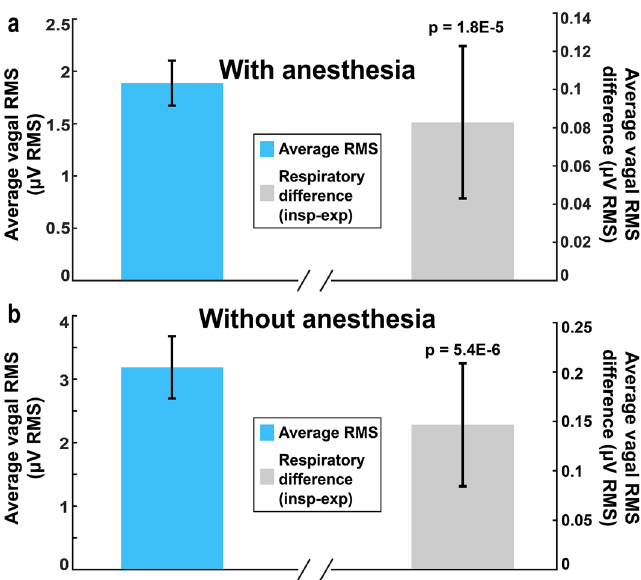
Figure 5. Average tonic RMS and respiratory vagal difference (RVD) using HR to signal respiration. ( a ) With anesthesia: Average RMS and 95% confidence interval in blue, RVD and 95% confidence interval in grey. Average RVD, calculated for 63 total recordings from 6 animals, was 0.0828 ± 0.14 µV RMS, which is significantly different from zero ( p = 1.8E−5). ( b ) Without anesthesia: Average RMS and 95% confidence interval in blue, RVD and 95% confidence interval in grey. Average RVD, calculated for 63 total recordings from 6 animals, was 0.15 ± 0.60 µV RMS, which is significantly different from zero ( p =